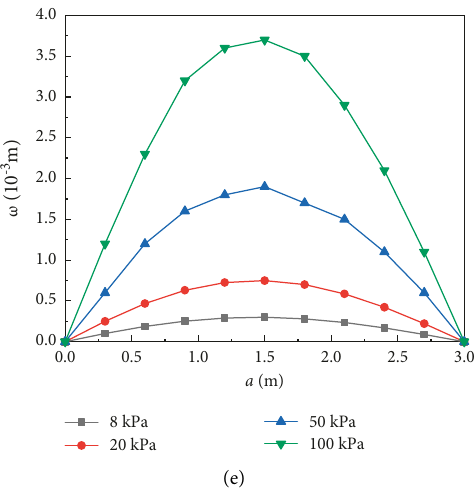
Figure 5: Effect of frost heaving force on deflection (w).